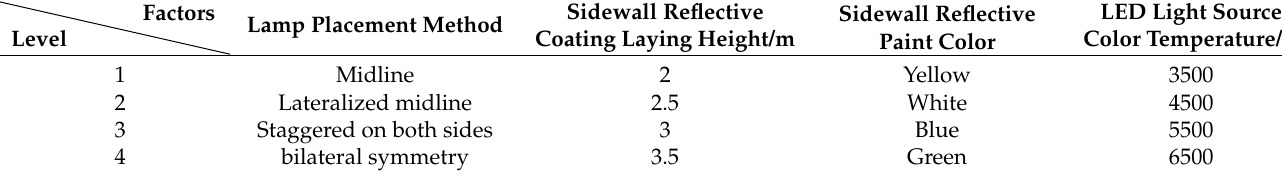
Table 2. Table of experimental factor